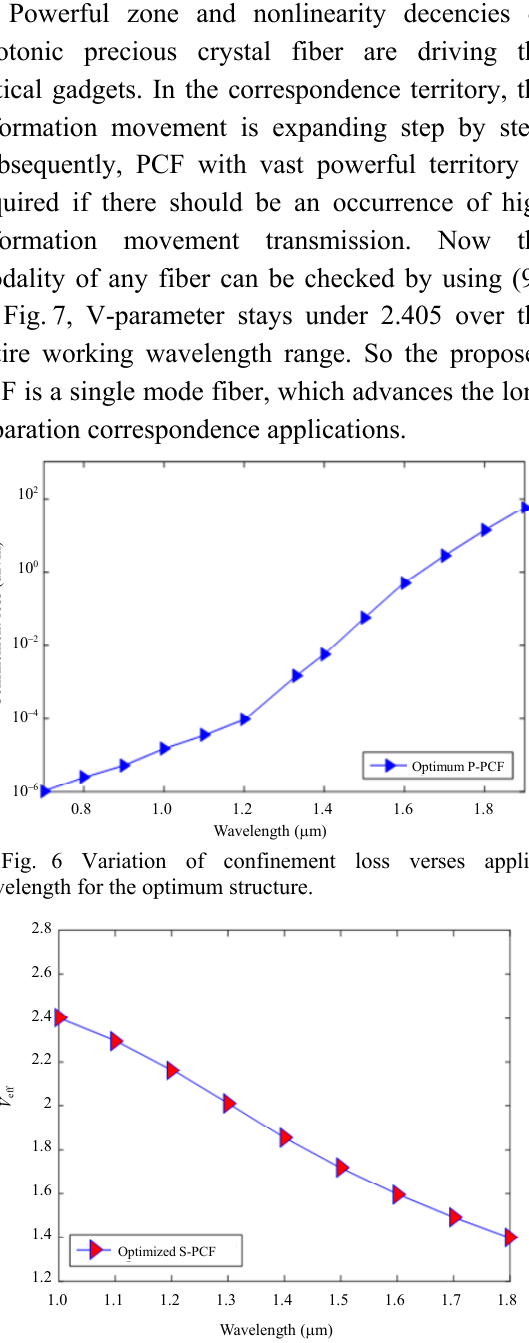
Fig. 7 V eff as a function of wavelength for the optimum structure.